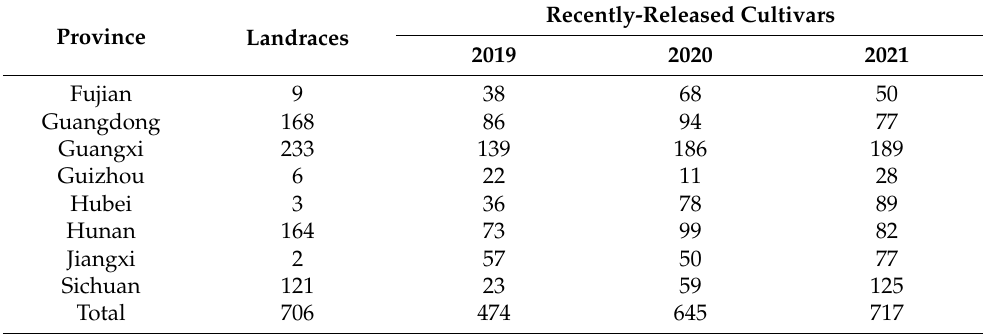
Table 1. Number of landraces and recently-released cultivars of indica rice for data collection. Province